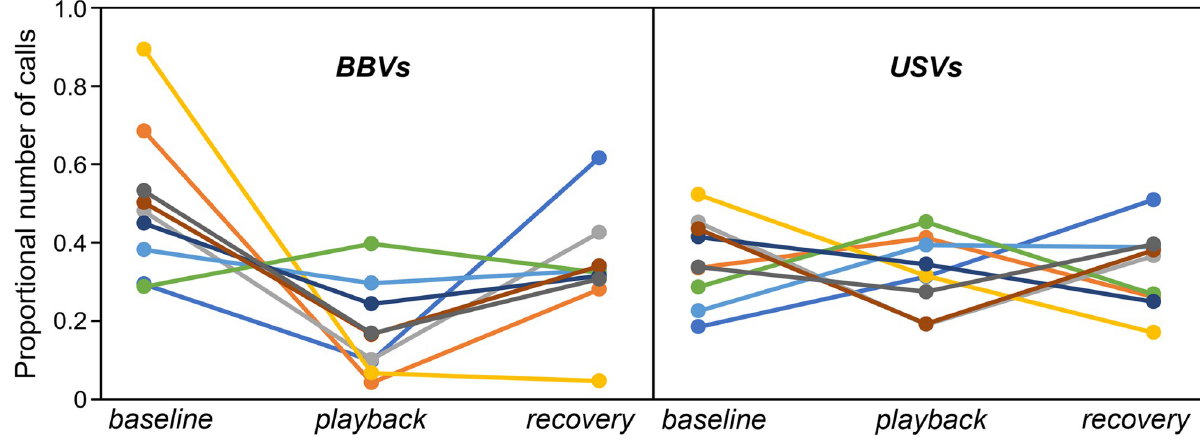
Fig 4. Plot of responses to playback of BBVs (left panel) versus USVs (right panel) in the same individuals (n = 9). Responses are presented as proportional USV numbers relative to all USVs in a given trial; for each trial, proportions in the three time bins (baseline, playback, and recovery) summate to 1. Specific colors represent responses of the same individuals to BBVs and USVs.